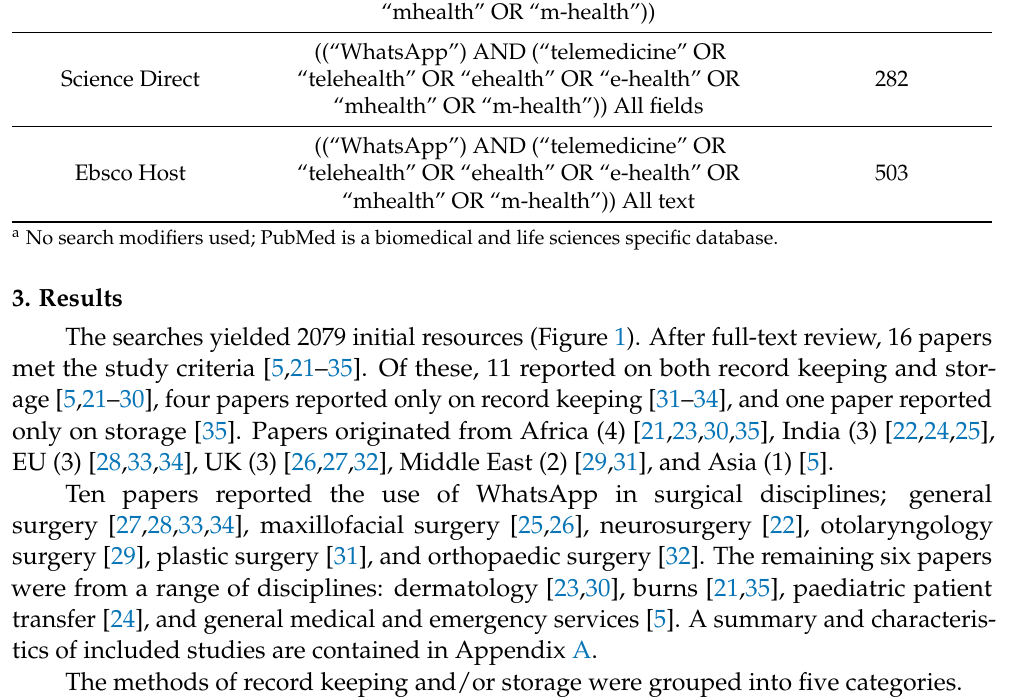
Table 1. Database, Search Strings and Resources Used for the Searches. Database Search Strings Resources PubMed “WhatsApp” [All fields] a 601 (ALL (“WhatsApp”) AND ALL (“telemedicine” OR Scopus “telehealth” OR “ehealth” OR “e-health” OR “mhealth” OR “m-health”)) ((“WhatsApp”) AND (“telemedicine” OR Science Direct “telehealth” OR “ehealth” OR “e-health” OR “mhealth” OR “m-health”)) All fields ((“WhatsApp”) AND (“telemedicine” Ebsco Host